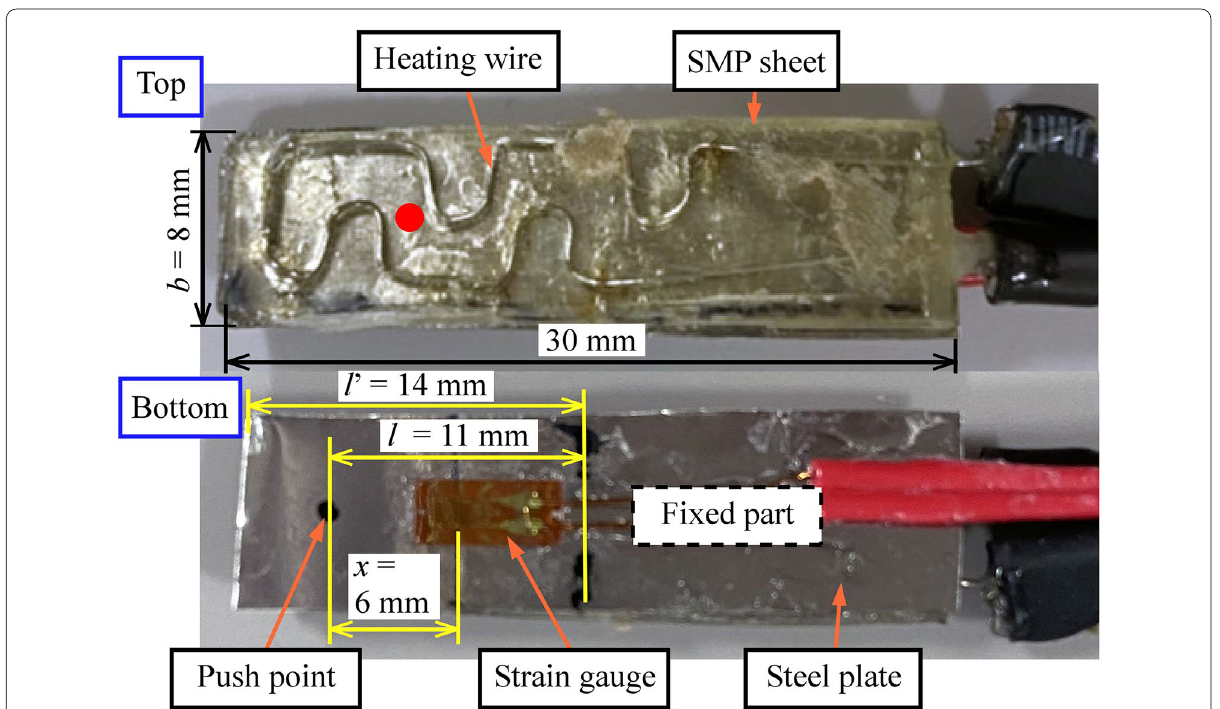
Fig. 2 Prototype force sensor using an SMP sheet with an embedded electrical heating wire (sample i). We attached a thermocouple to the surface of the SMP sheet at the position indicated by the red circle